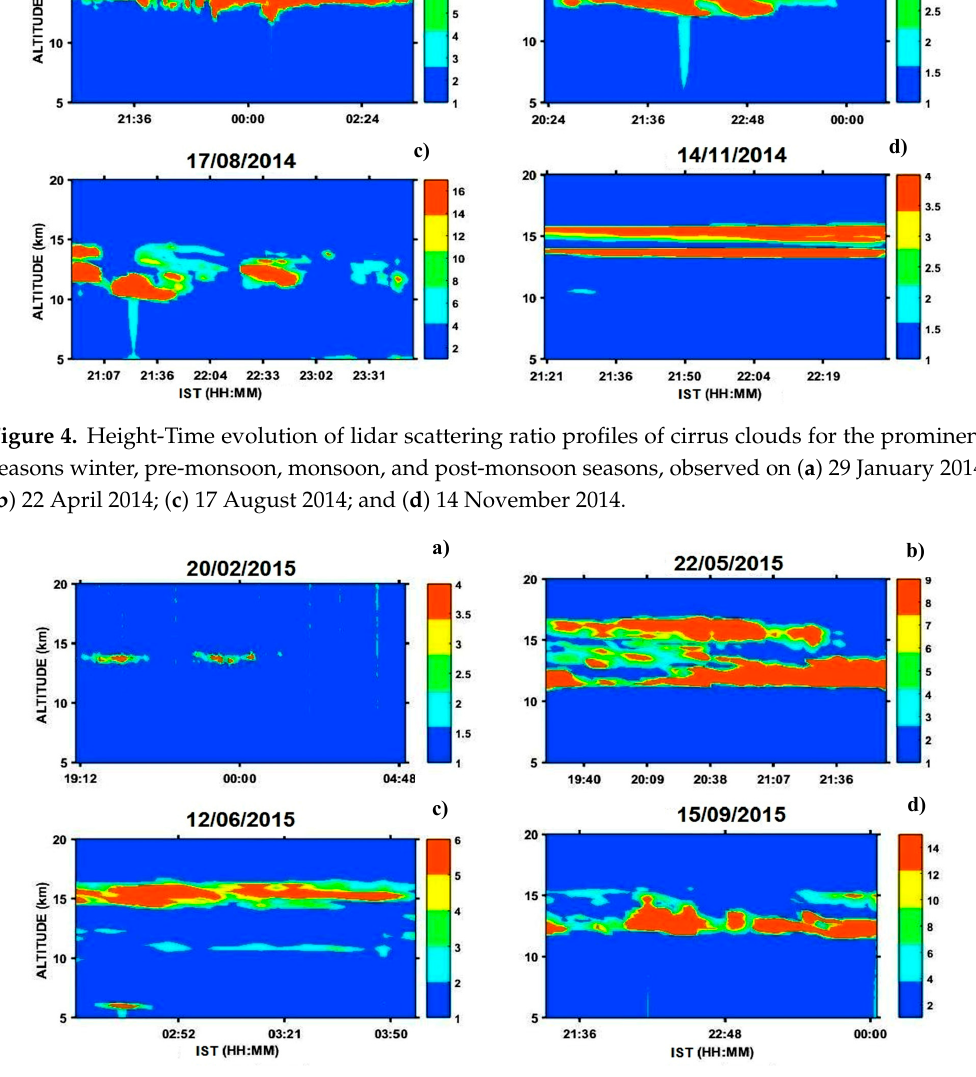
Figure 5. Height-Time evolution of lidar scattering ratio profiles of cirrus clouds for the prominent seasons winter, pre-monsoon, monsoon, and post-monsoon seasons, observed for the year 2015 during the nights on ( a ) 20 February 2015; ( b ) 22 May2015; ( c ) 12 Jane 2015; and ( d ) 15 September 2015.